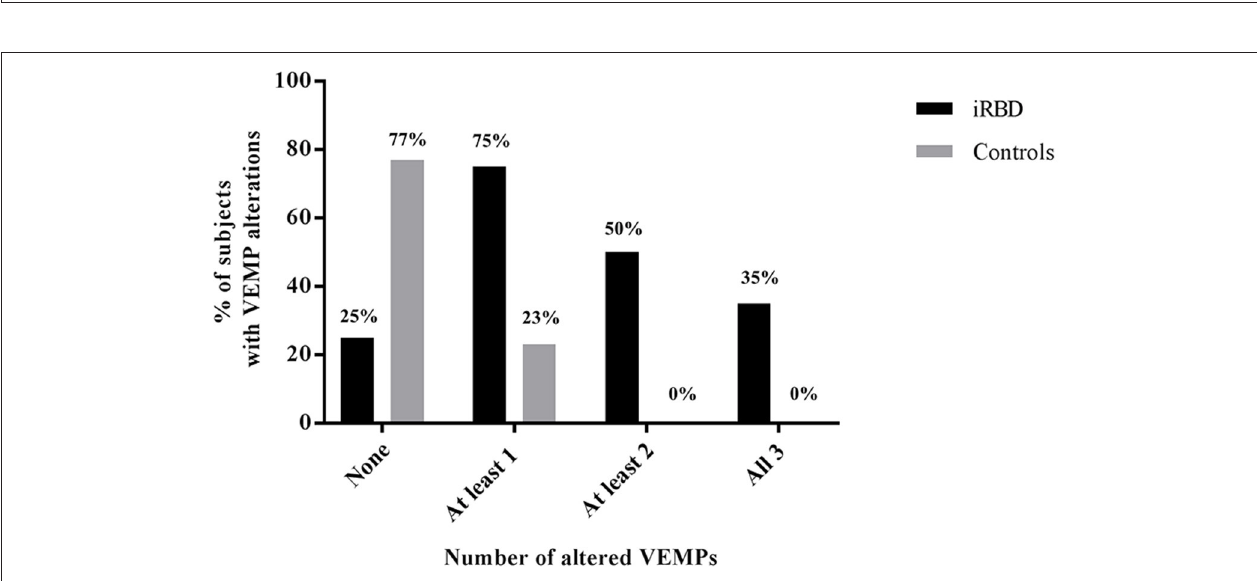
FIGURE 3 | Cumulative percentage of patients and controls subjects displaying alterations in none, one, two, or all the three VEMPs.